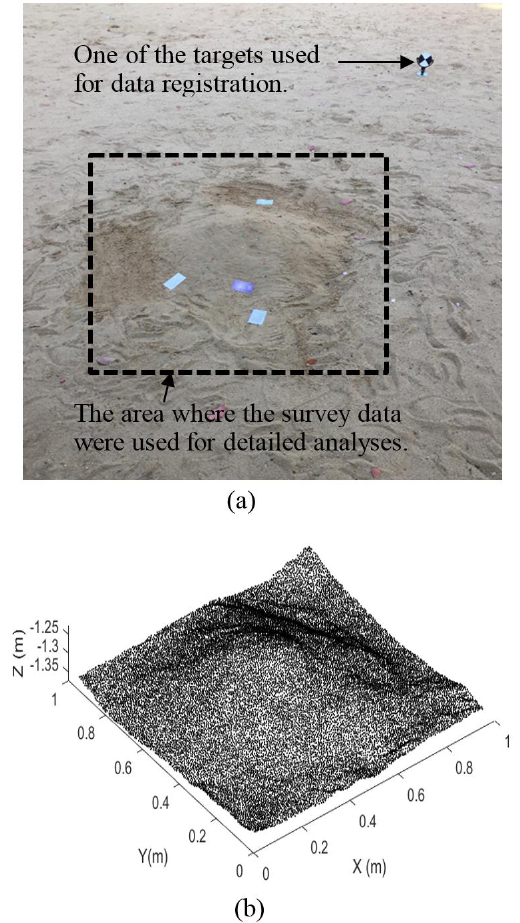
Figure 1. (a) The study site; (b) The SfM-derived point cloud. The point cloud obtained using the scanner for the sub-area consisted of approximately 22000 data points (referred to as TLS-whole), which is equivalent to an average data spacing of approximately 6.8 mm. The densities of the point clouds derived from images varied with the quality settings used in the data processing. The point cloud (referred to as Photo-whole) derived from images using highest quality settings is shown in Figure 1b, which is a thinned point cloud (using the minimum distance method) of the original one to match the density of the TLS data. Based on the TLS-whole point cloud, two subset point clouds were generated: TLS-subset1 and TLS-subset2. These two subset point clouds did not share the same data points, and each had approximately 8000 data points